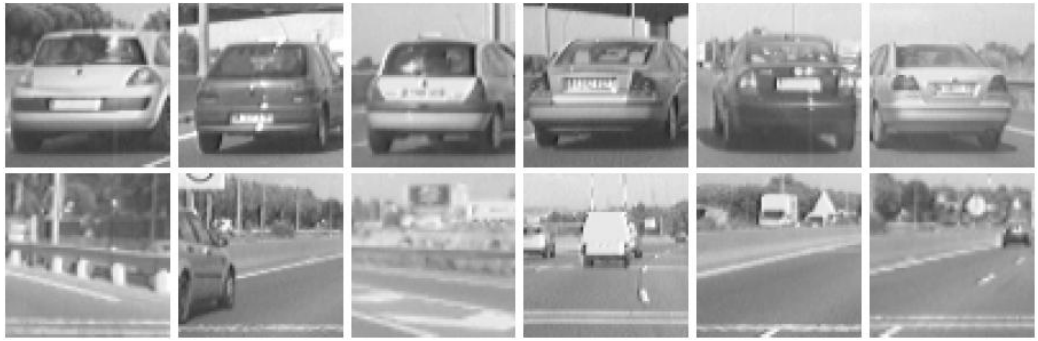
Figure 10. Forward data set. Upper row: positive samples (vehicles); Lower row: negative